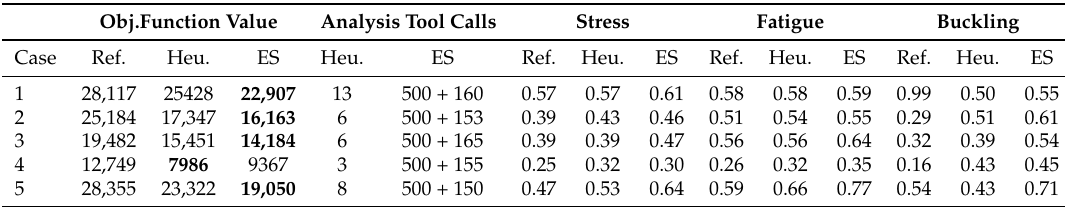
Table 1. Results of the boom configuration